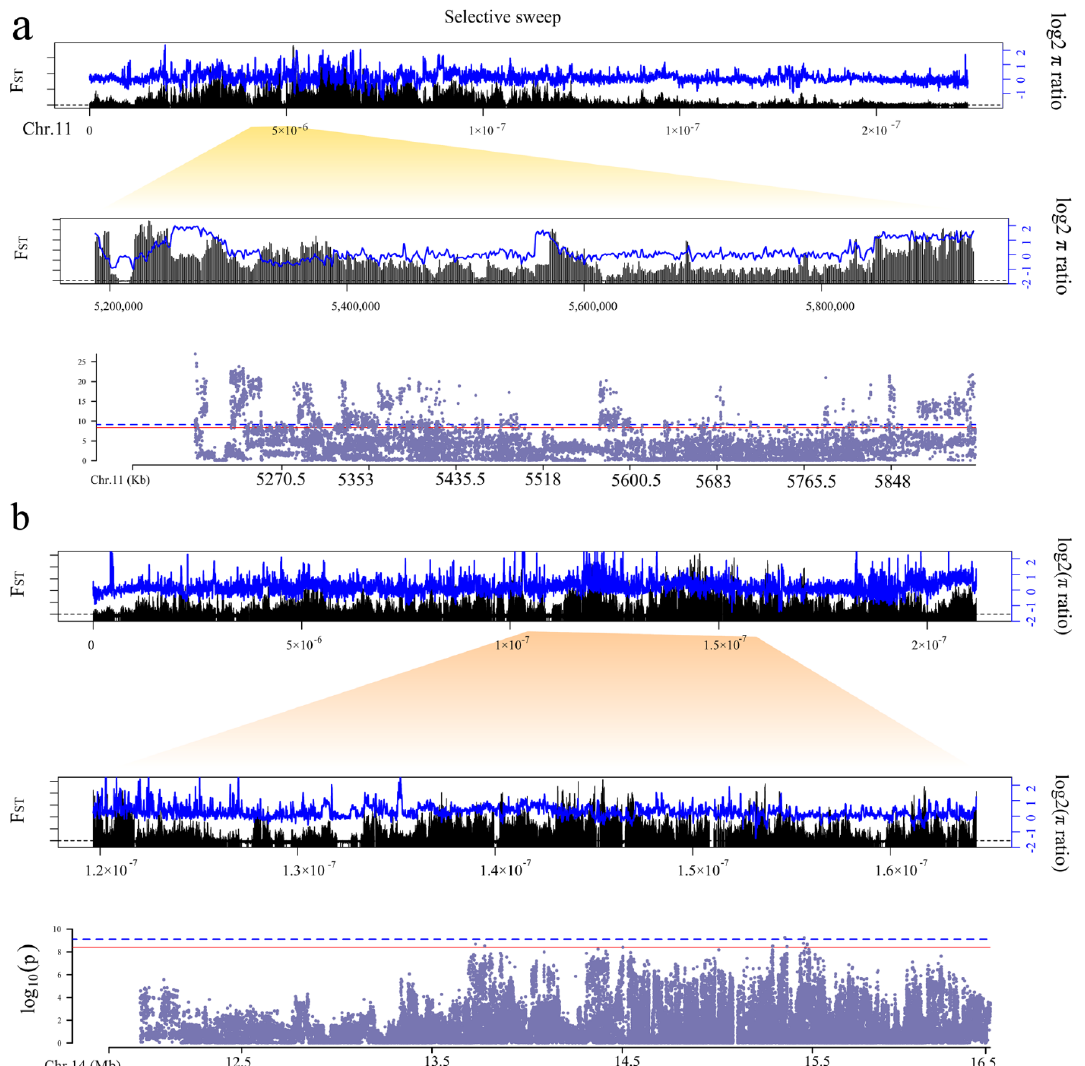
Figure 6. Signatures of selection of white ( a ) and black ( b ) plumage in duck. The blue dashed line represents a threshold of 7.897699 × 10 − 10 and the red solid line represents a threshold of 3.948849 × 10 − 9 .